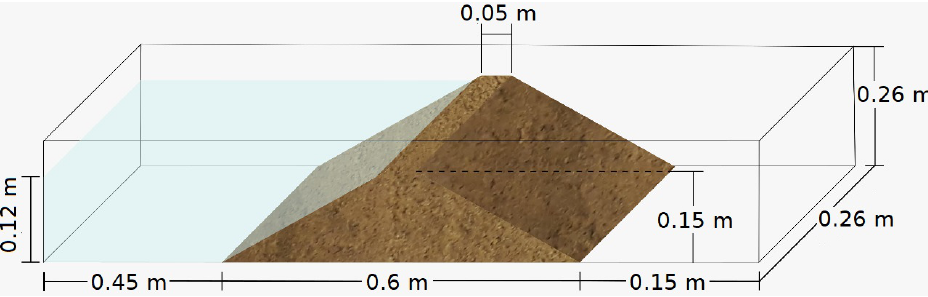
Figure 2. Geometry of the SM dam.